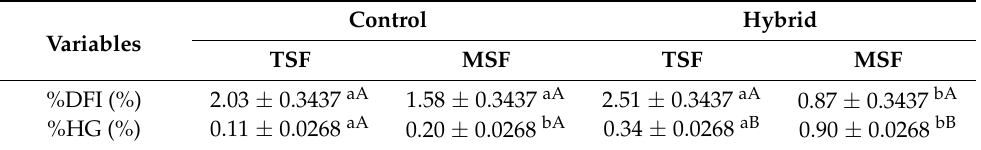
Table 2. Results of Sperm Chromatin Structure Assay obtained from flow cytometry analysis, for animal and sperm fraction. Control Hybrid Variables TSF MSF